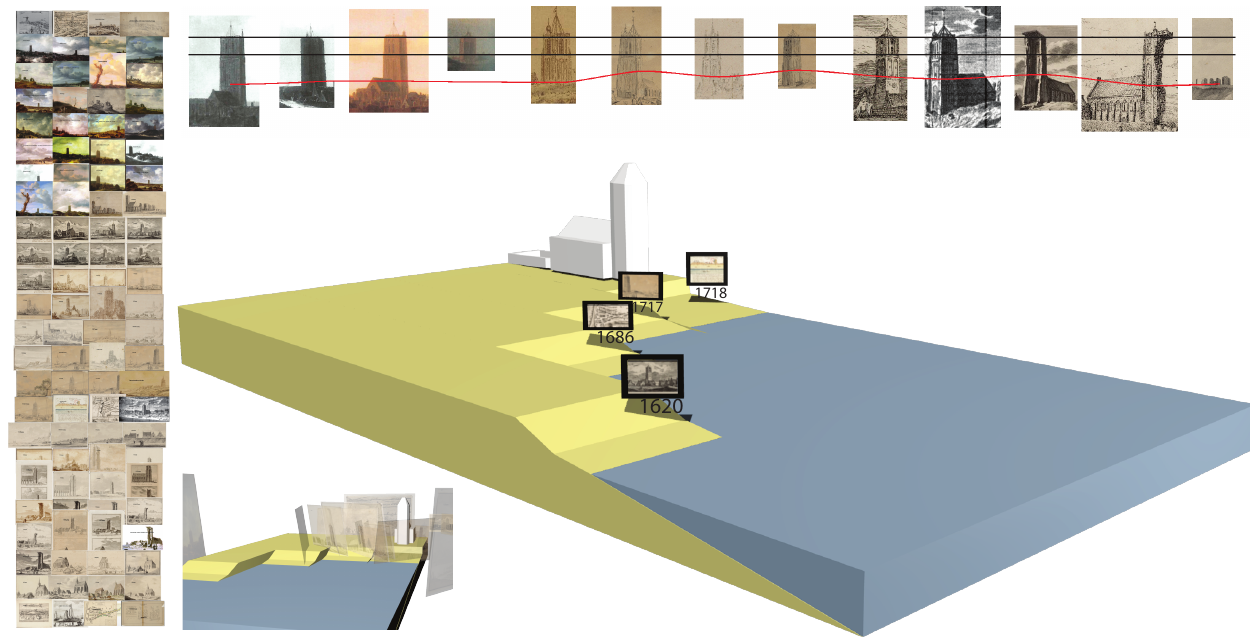
Fig. 2. Left: overview of the paintings and sketches used in the reconstruction. Top: determining the painter reliability by comparing the ratio between the upper two parts of the Egmond aan Zee church tower. Bottom: 3-D reconstruction of the coastal town of Egmond aan Zee. Center: four reconstructed profiles for the years (from front to back) 1620, 1686, 25 December 1717 and 8 February 1718.